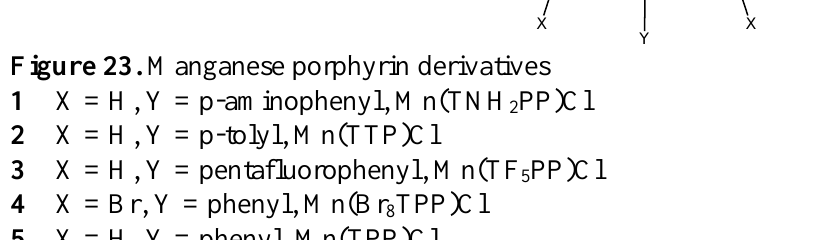
Figure 23. Manganese porphyrin